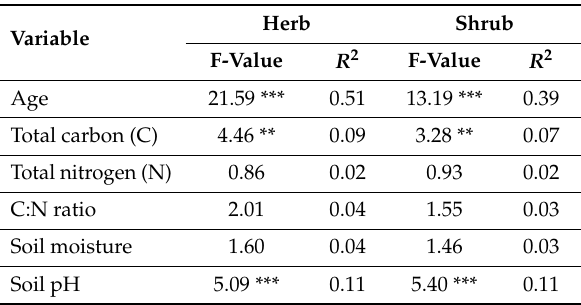
Table 3. Permutational multivariate analysis of variance (perMANOVA) examining the influence of the stand age, total soil carbon, total soil nitrogen, C:N ratio, soil moisture, and soil pH content on the herb and shrub species composition. Significance of main e ff ects are shown as: ** p < 0.01, *** p < 0.001, and R 2 is the fit index of the model.